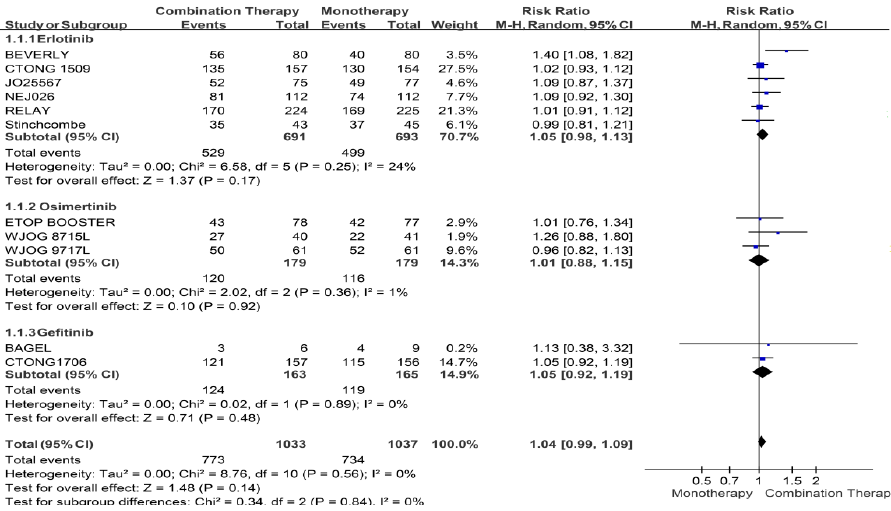
Figure A3. Forest plot and pooled response ratio for